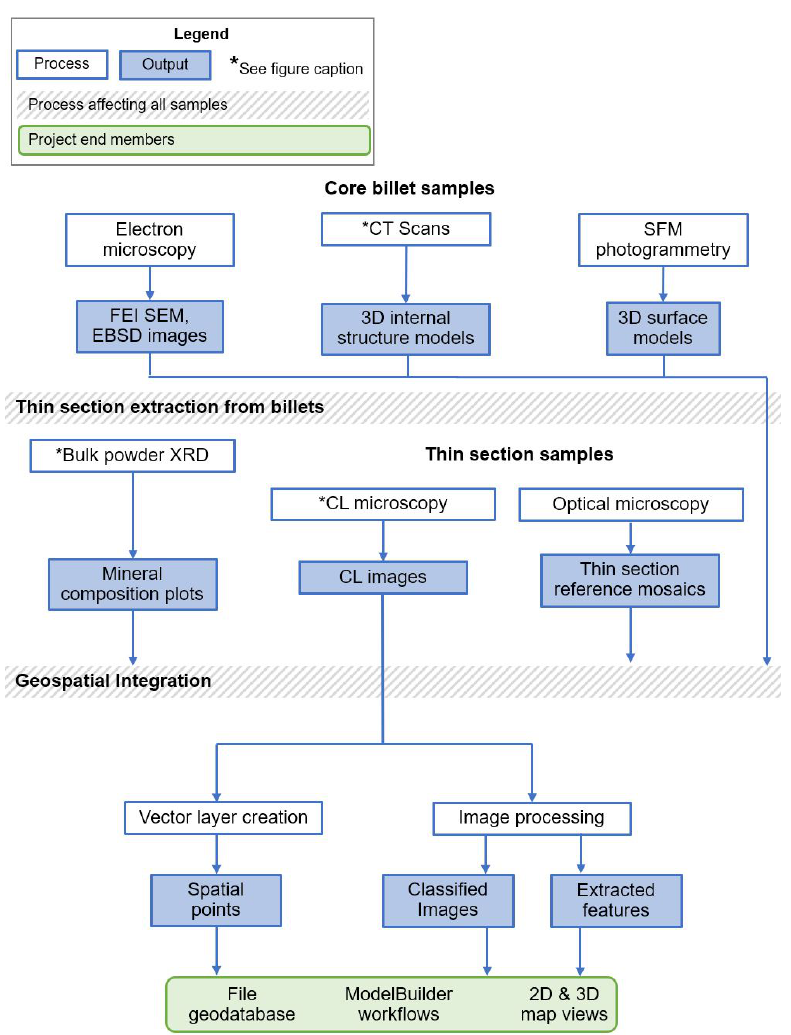
Figure 1. Workflow diagram of in situ data collection, processes, and resulting outputs under a GIS-based framework. Starred items indicate procedures carried out by third parties (see